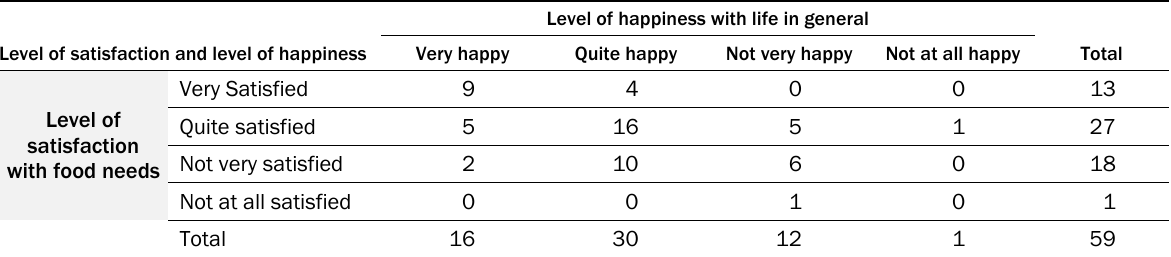
Table 6. Cross Tabulation of Levels of Food Needs Satisfaction and Overall Happiness